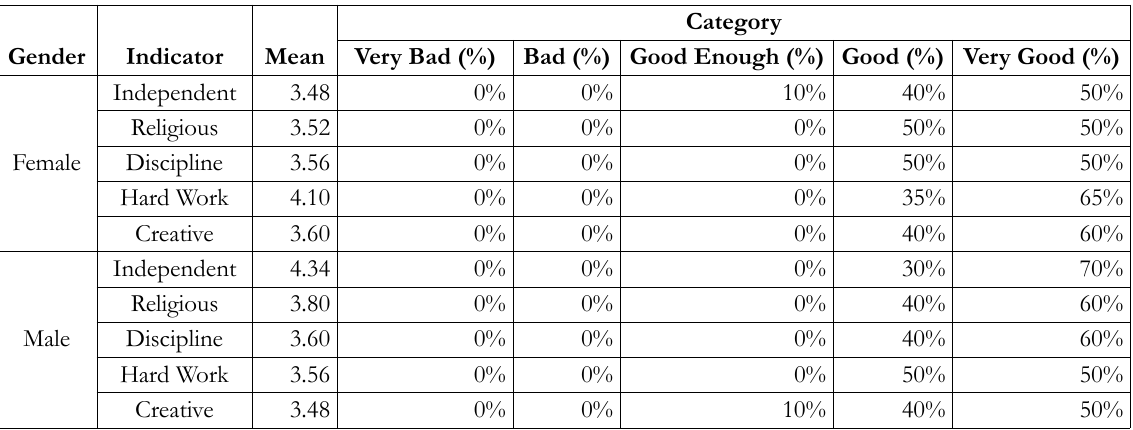
Table 12. Character Description of Seventh Grade Students based on Student Character Indicators Gender